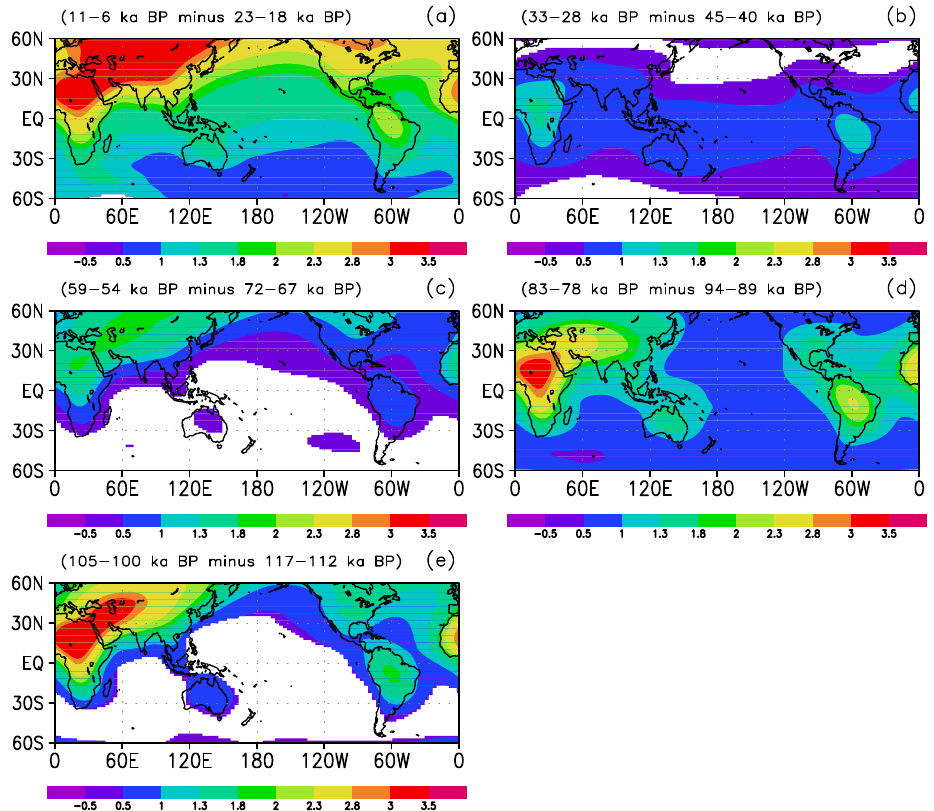
Fig. 6. Composite differences in the simulated August–September SAT between the mean values of the extreme warm and cold phases (the former minus the latter) of the five precession cycles in the Guliya August–September SAT, in which the times of the extreme warm and cold phases are indicated above each panel. The shaded areas represent the values significant at the 95% confidence level.